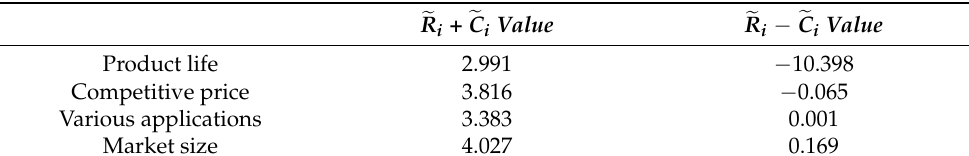
  ( ) def C value + and value − of the impacts of the four cri- def def Table 4. The sum i value and ( (cid:101) R i − (cid:101) C i ) value of the impacts of the four criteria of the Table 4. The sum ( (cid:101) R i + (cid:101) C i ) teria of the market benefit. market benefit.